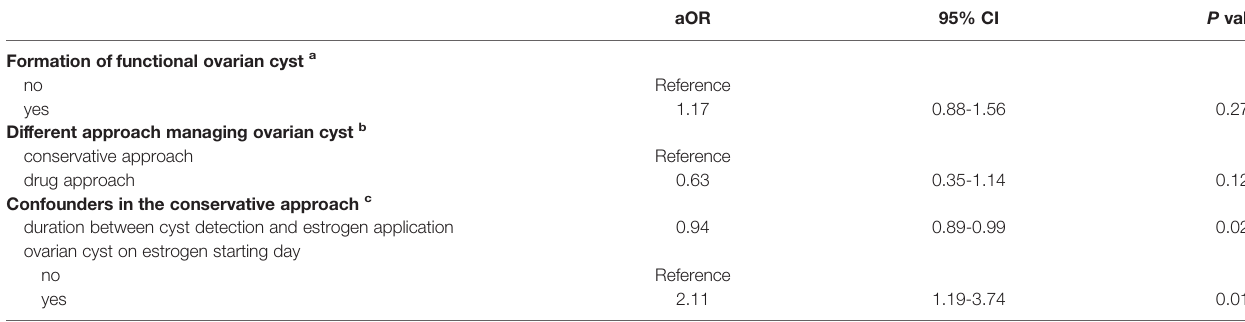
TABLE 5 | Variables associated with live birth rate: multivariate logistic regression analysis.